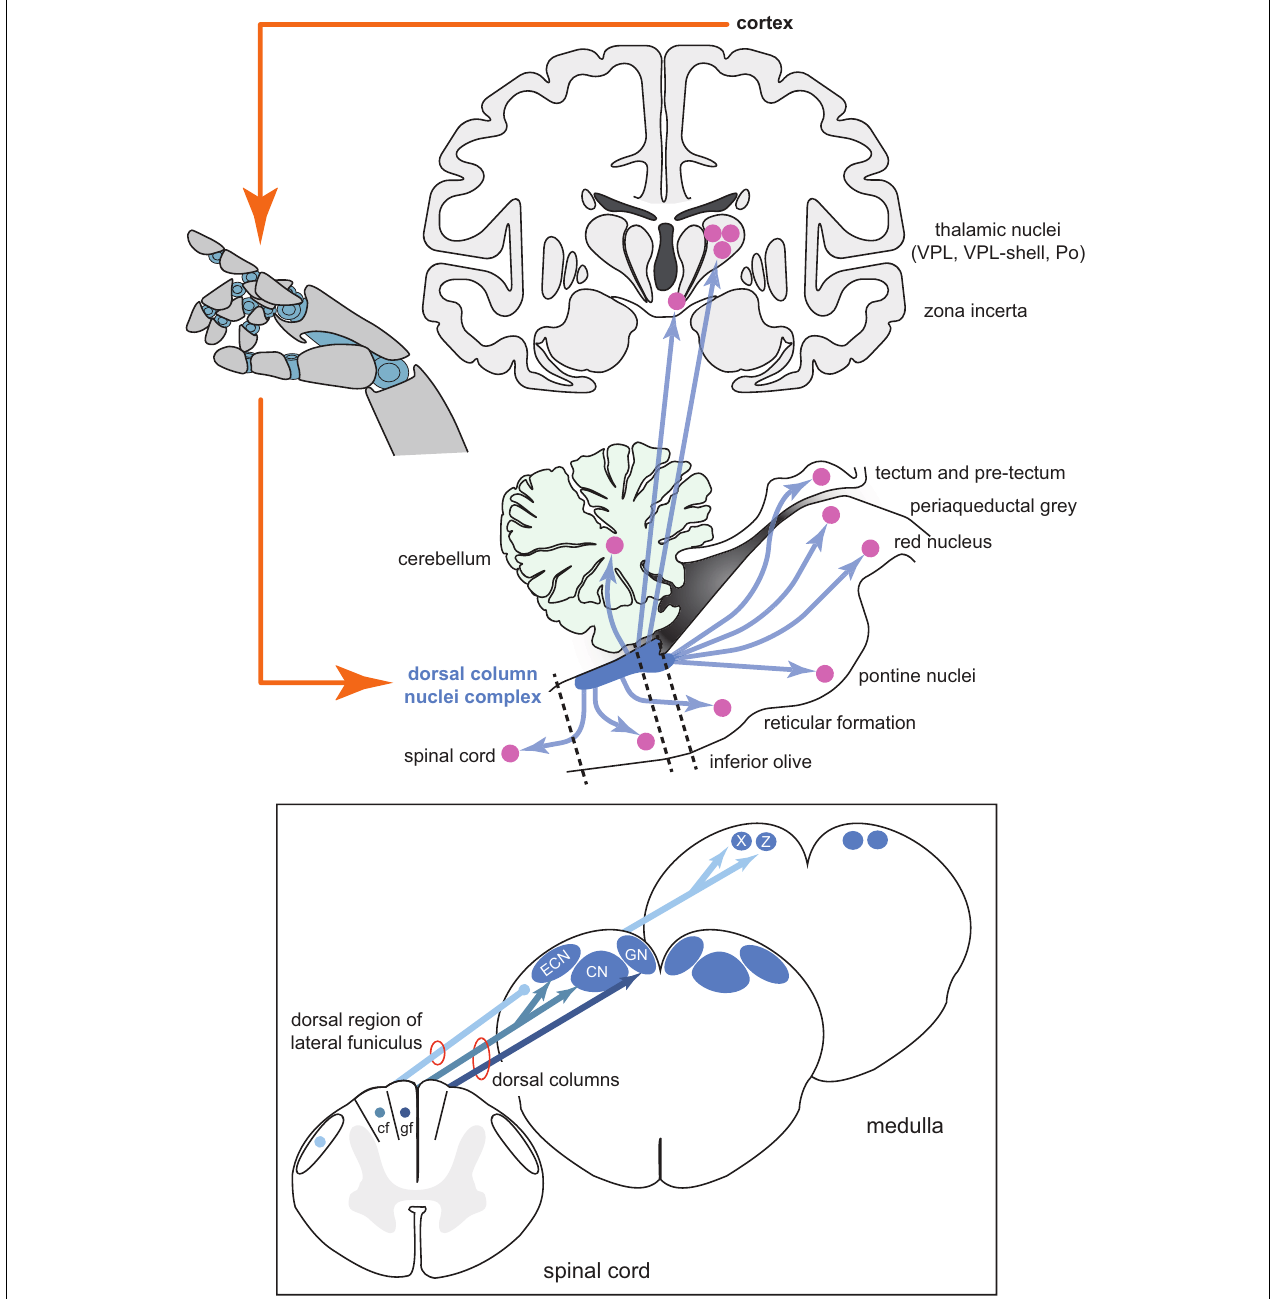
FIGURE 1 | Schematic diagram of the inputs and projections of the dorsal column nuclei complex and information flow of a potential neural prosthesis with brainstem somatosensory feedback. Shown are schematic views of the forebrain (coronal section, top), hindbrain (parasagittal section, bottom), and spinal cord and medulla (transverse sections, insert). The dorsal column nuclei complex (DCNc; collectively: CN, GN, ECN, X and Z) projects to many sensorimotor targets in addition to the commonly described pathway through the ventroposterior lateral nucleus (VPL) of the thalamus. Providing sensory feedback by cortical stimulation bypasses these other essential targets involved in sensorimotor function. Compared to the cortical approach, a DCNc somatosensory neural prosthesis would provide a more realistic quality sensorimotor experience by accessing these other key sensorimotor regions. Dashed lines indicate spinal cord and brainstem cross-sections shown in the insert. Insert: The DCNc receives upper and lower body cutaneous and proprioception-related afferents via the cf and gf of the dorsal columns, respectively. Some lower body proprioception-related, and mixed modality upper and lower body afferents, travel to the DCNc via the dorsal region of the lateral funiculus including, but not limited to, the dorsal spinocerebellar tract. These afferents primarily synapse in X and Z. Therefore, to adequately restore all tactile and proprioceptive elements of somatosensation, the entire DCNc may require targeting. Abbreviations: cf, cuneate fasciculus; CN, cuneate nucleus; ECN, external cuneate nucleus; gf, gracile fasciculus; GN, gracile nucleus; Po, posterior group of the thalamus; VPL, ventroposterior lateral nucleus of the thalamus; X, nucleus X; Z, nucleus Z.